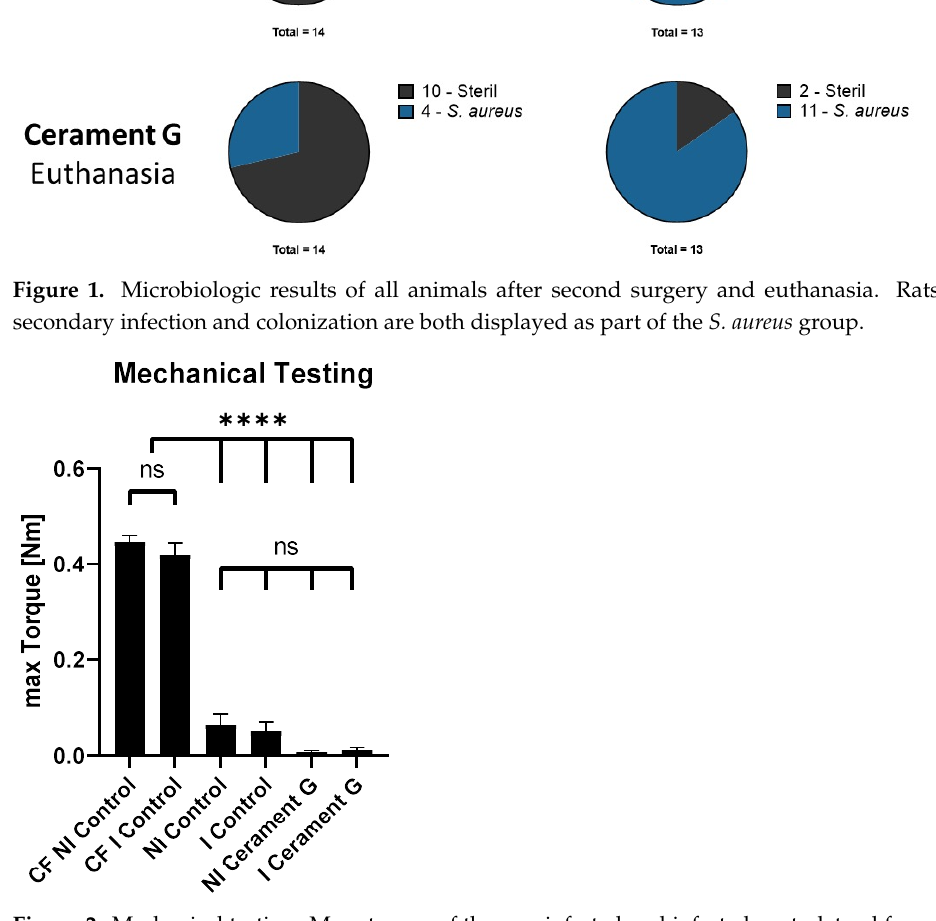
Figure 2. Mechanical testing. Max. torque of the non-infected and infected contralateral femora (CF NI Control + CF I Control) is significantly higher than the max. torque of all of the other groups. No significant differences between all of the other groups were detected. **** = p < 0.0001, ns = not sig- nificant . 3.4. μ-CT Analysis of the Surrounding Bone Showed an Osteoinductive Effect by Cerament G µ-CT analysis of the surrounding bone showed a significant increase in percent bone volume four and eight weeks after the second surgery between the infected and non-in- fected control groups and the corresponding groups treated with Cerament G. This effect diminished for the non-infected groups after four weeks (Figure 3). A comparable situa- tion could be observed for the bone surface density, whereas significances were found in the non-infected groups only after four weeks and in the infected groups only after eight weeks. The trabecular number is significantly increased in the groups with Cerament G four weeks after the second surgery. Osteoinduction and anti-infective prophylaxis by Cerament G was indicated by a significant reduction in trabecular separation and total porosity between the control and therapy groups four and eight weeks after the second surgery (Figure 3).